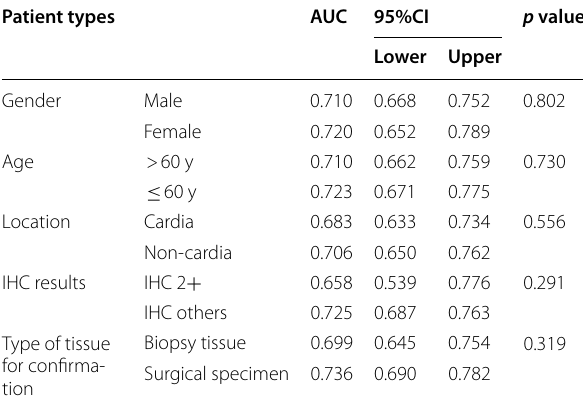
Table 4 The performance of the radiomic nomogram in stratified